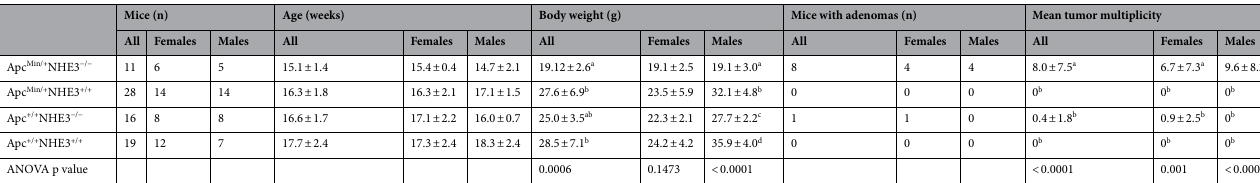
unaffected regions and cancer (Fig. 1C, right panel; p = 0.0002), with 83% (20 out of 24) tested patients showing decreased NHE3 expression in cancer biopsies as compared to a non-affected region. NHE3 deficiency exacerbates tumor formation in Apc Min/+ mice. Loss of NHE3 in mice is associ- ated with chronic inflammation and with gut microbial dysbiosis 14,15,18,20,30 . Colitis developed in NHE3 −/− mice is microbiota-dependent and rederivation into a barrier facility (utilized in this study) dramatically reduces mucosal inflammation in this strain 20 . To investigate whether loss of NHE3 affects CRC development, we crossed NHE3 −/− mice onto Apc Min/+ background. We have generated 136 mice in the F2 generation. Due to an increased mortality observed in Apc Min/+ NHE3 −/− and Apc +/+ NHE3 −/− mice under 18 weeks of age (56% and 27%, respectively), 116 mice remained available for the study. NHE3 +/− mice, regardless of the Apc status, displayed a phenotype indistinguishable from NHE3 +/+ littermates (data not shown), and were disregarded in further analyses. Overall, we analyzed 74 mice: 39 on Apc Min/+ background (20 females and 19 males) and 35 on Apc +/+ background (20 females and 15 males), with an average age 15.7 weeks and 17.1 weeks respectively (Table 1). Within this relatively early time frame, and in the microbial environment of a barrier facility where the mice where housed, and consistent with our prior work, Apc +/+ NHE3 −/− mice did not present with overt histopathological colitis as evaluated by an unbiased pathologist and exemplified in Fig. 2B,C. Minor increases in mucosal cytokine (IL6, TNF, IFNg, IL22) and NOS2 mRNA expression were not statistically significant (Fig. 2C). Compared to other genotypes, mice in the Apc Min/+ NHE3 −/− group had significantly lower body weight (Table 1, Fig. 2A). Colorectal adenomas were observed in all 4 out of 5 Apc Min/+ NHE3 −/− males and in 4 out of 6 Apc Min/+ NHE3 −/− females. Tumor multiplicity was 12 ± 7.3 and 10 ± 6.7 males and females, respectively, with no statistical significance between sexes (Table 1, Fig. 2).